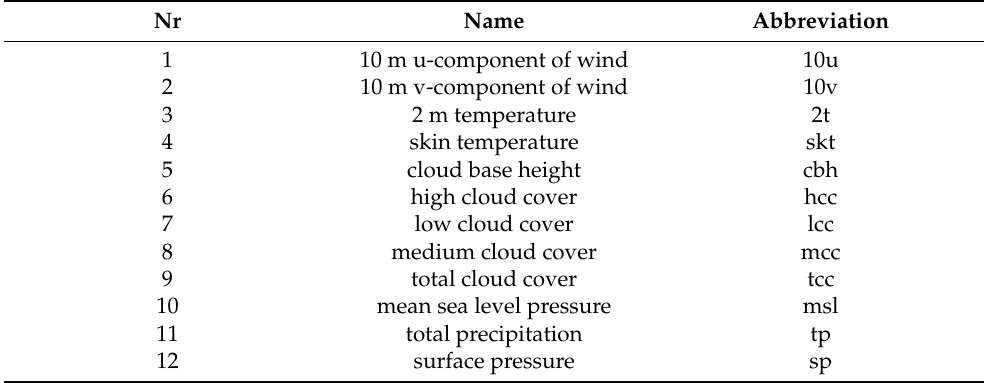
Table 2. ERA5 surface